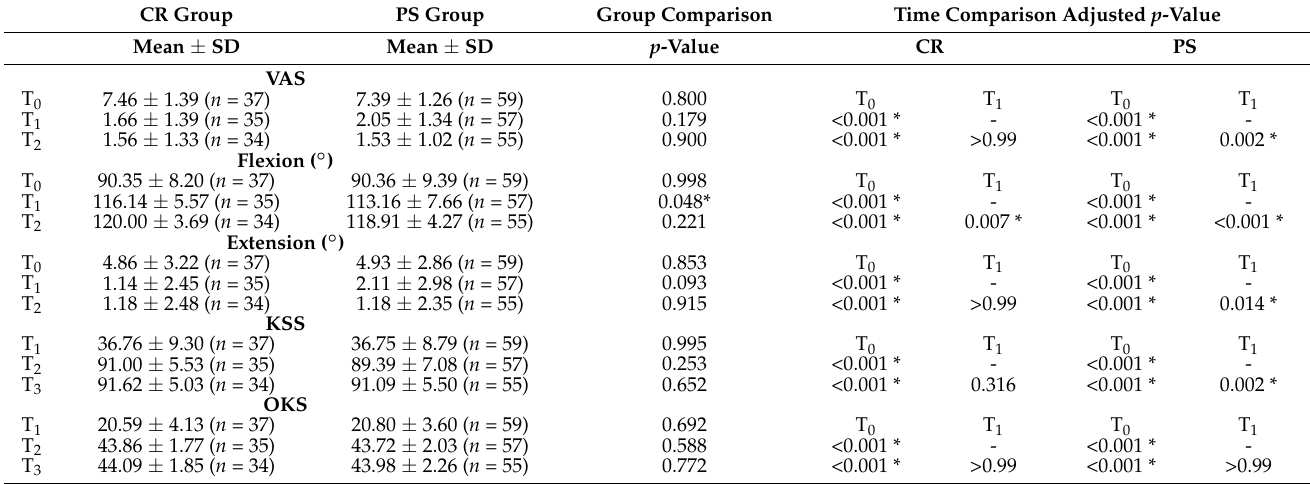
Table 2. Clinical comparisons between groups at each postoperative follow-up.